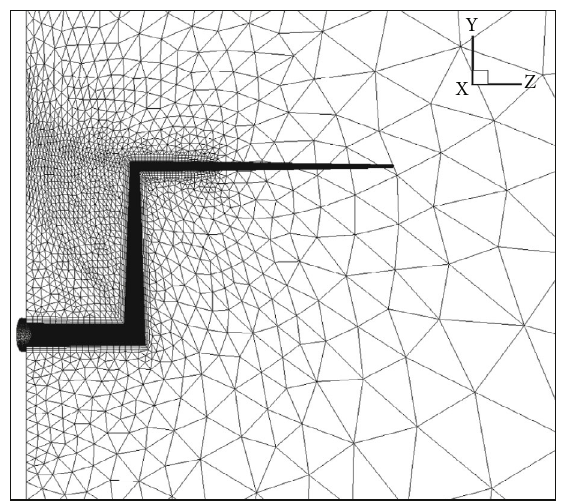
Figure 6: Internal mesh at 90 ° folding